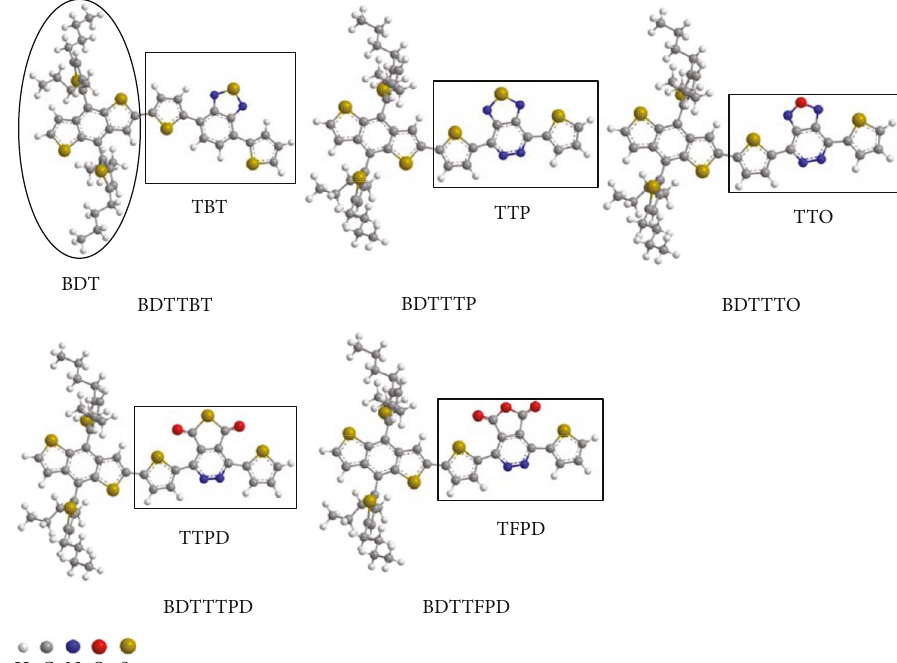
Figure 2: The stereograph of optimized parent molecules of copolymers by